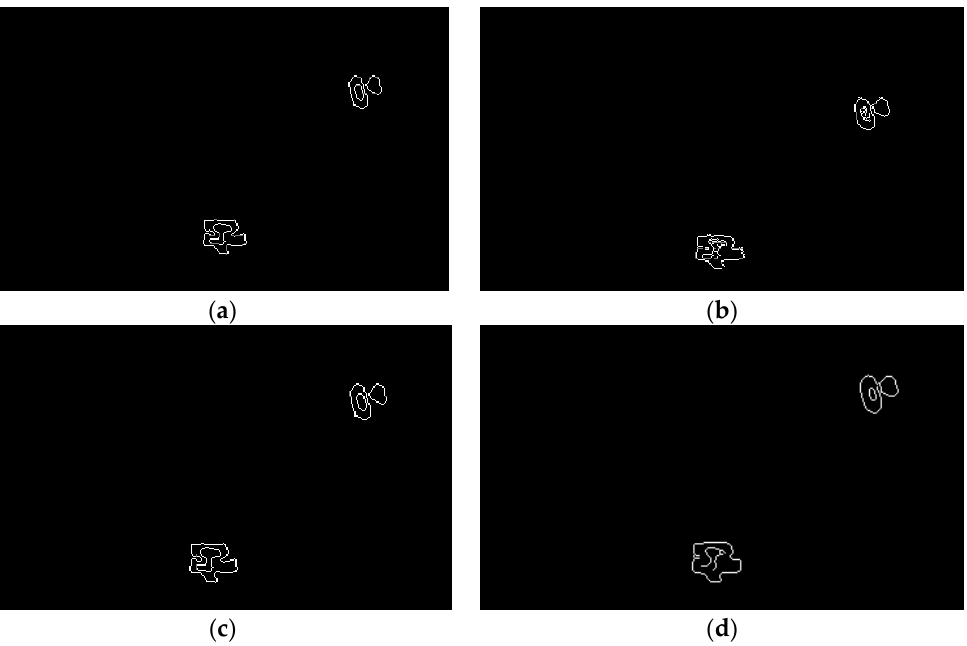
Figure 6. Different operators on wear debris edge hyper-heuristic detection ( a ) Sobel operator. ( b ) Prewitt operator. ( c ) LOG operator. ( d ) Canny operator.